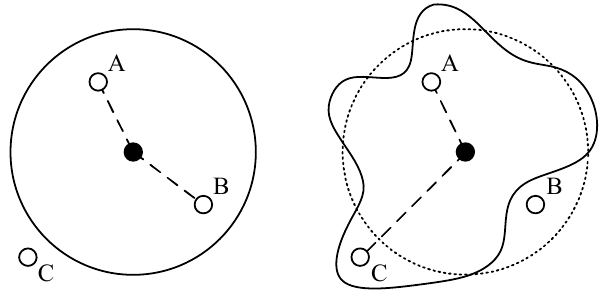
Figure 1. Transmission ranges for the two-ray ground reflection model (left) and the shadowing model